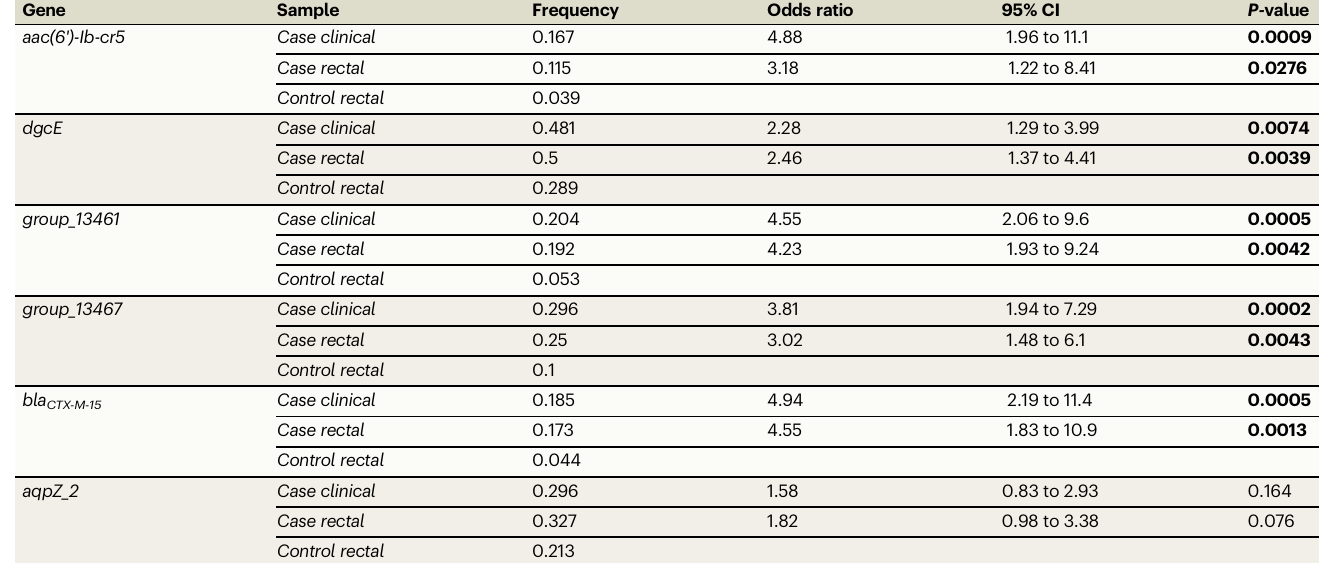
Table 4 | Gene association with positive clinical cultures in a geographically independent cohort of Klebsiella colonized